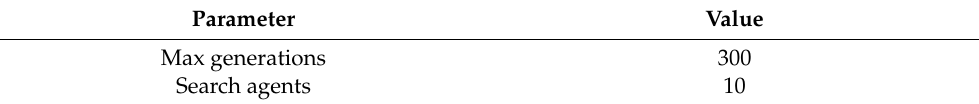
Table 14. Parameters of the GWO algorithm.